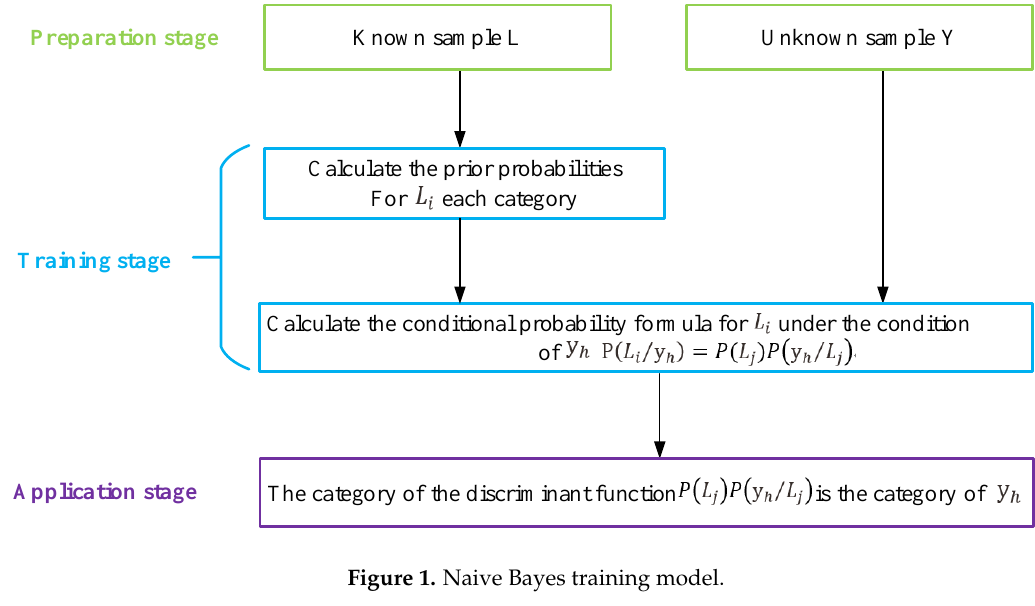
Figure 1. Naive Bayes training